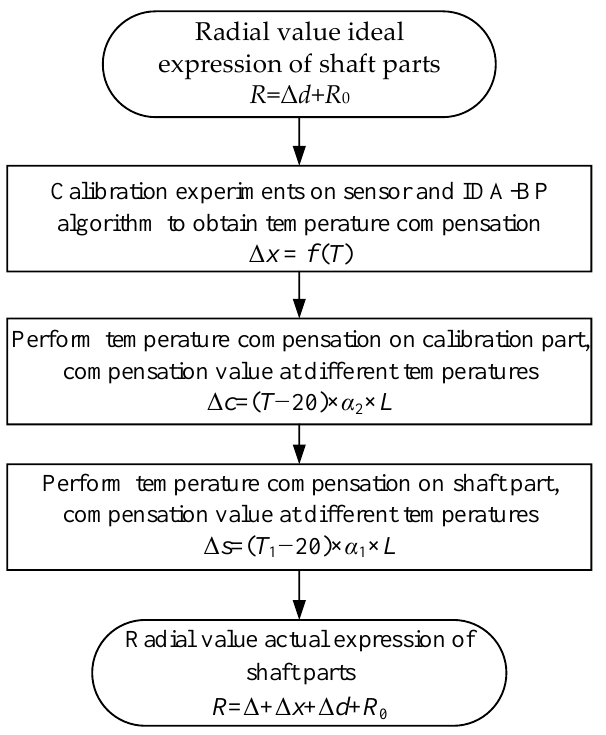
Figure 2. Flow chart of the temperature compensation for crankshaft measurement.